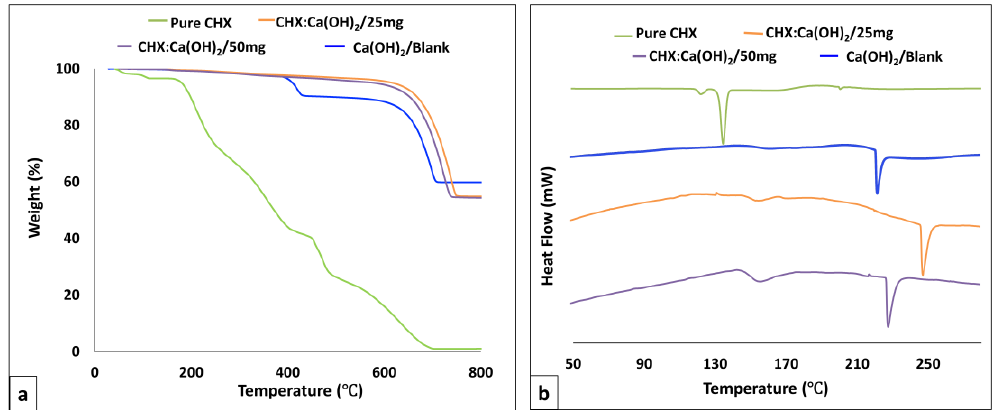
Figure 5. ( a ) Representative Thermogravimetric Analysis (TGA) profiles displaying the spectra of the pure Chlorhexidine (CHX), the unloaded Ca(OH) 2 microparticles [Ca(OH) 2 /Blank], and the CHX-loaded/Ca(OH) 2 microparticles at the formulations of CHX:Ca(OH) 2 /25 mg and CHX:Ca(OH) 2 /50 mg respectively. The Ca(OH) 2 /Blank microparticles showed decomposition at approximately 350–400 ◦ C. Pure CHX has demonstrated weight-loss at ~100 ◦ C whereas its entrapment in Ca(OH) 2 microparticles shifted degradation to higher temperatures (~450–500 ◦ C). Therefore, entrapment procedure has resulted in structural changes in CHX-loaded/Ca(OH) 2 microparticles ( b ) Representative DSC thermograms showing the spectra of the pure Chlorhexidine (CHX), the Ca(OH) 2 /Blank microparticles, and the CHX-loaded/Ca(OH) 2 microparticles at the formulations of CHX:Ca(OH) 2 /25 mg and CHX:Ca(OH) 2 /50 mg respectively. The endotherm peaks of Ca(OH) 2 /Blank were observed at ~222.38 ◦ C. Upon CHX incorporation, CHX endotherm peaks were displaced to a temperature of ~250.28 ◦ C and ~235.40 ◦ C in CHX:Ca(OH) 2 /25 mg and CHX:Ca(OH) 2 /50 mg, respectively, confirming the presence of CHX in these formulations. Absence of the detectable CHX domains (~136 ◦ C) in the spectra of microparticles indicated uniform CHX dispersion in the Ca(OH) 2